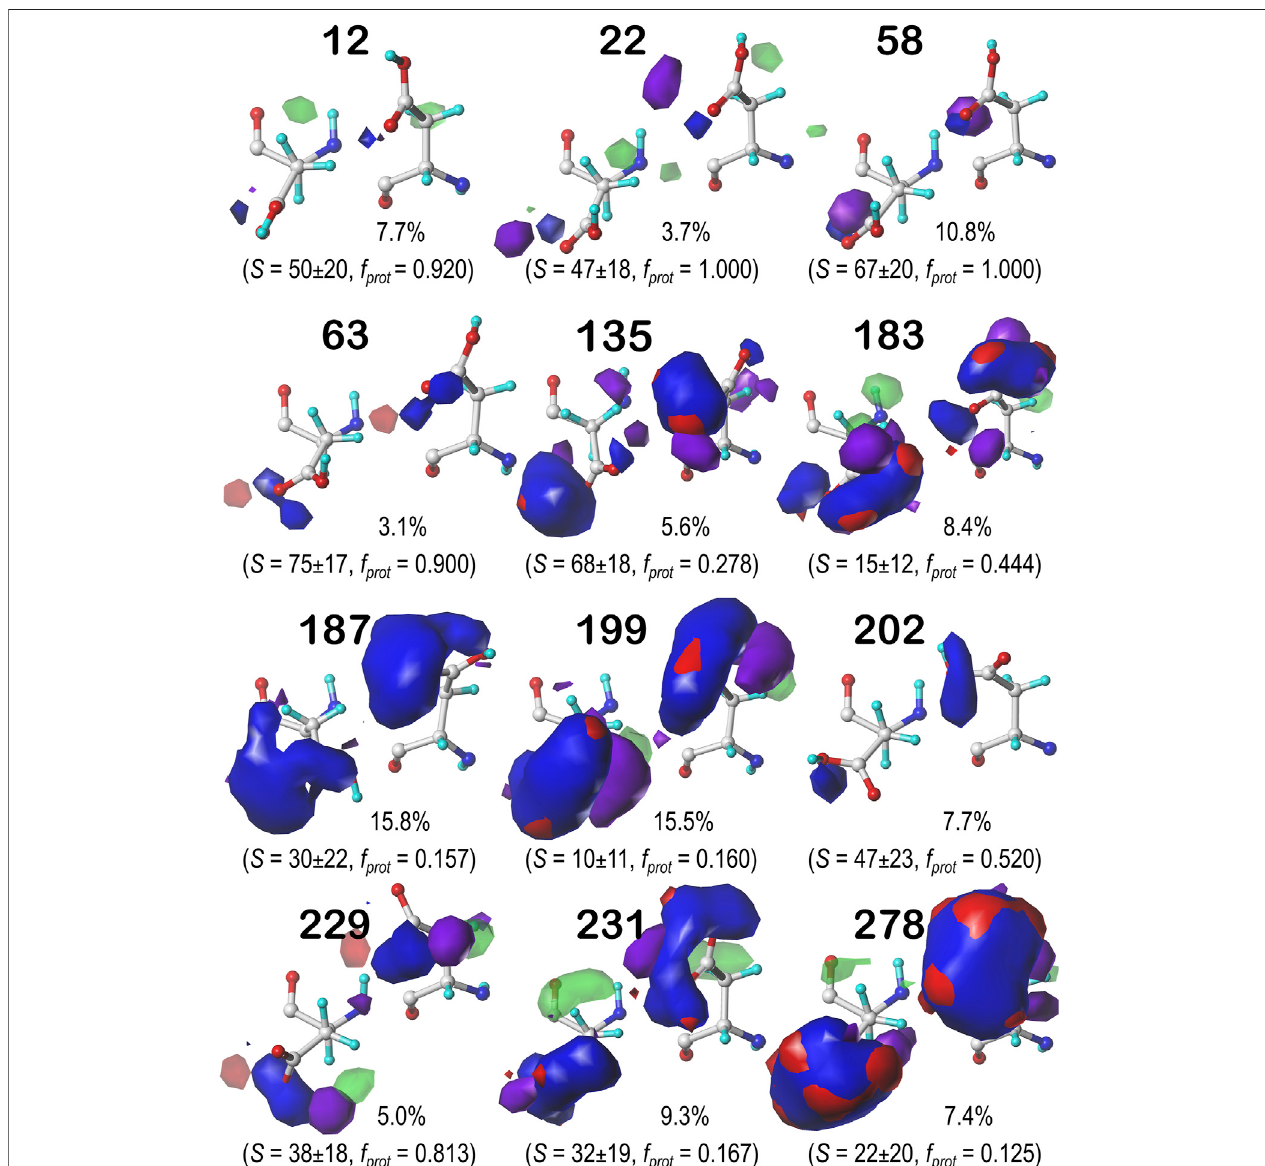
FIGURE8| HydropathicinteractionmapsdisplayingtheGaussian-weightedaveragesidechainenvironmentsofasparticacidinthe χ 1 (cid:1) 180 ° parseofthe b1 chess square at pH (cid:1) 3.345. See caption for Figure 7 .